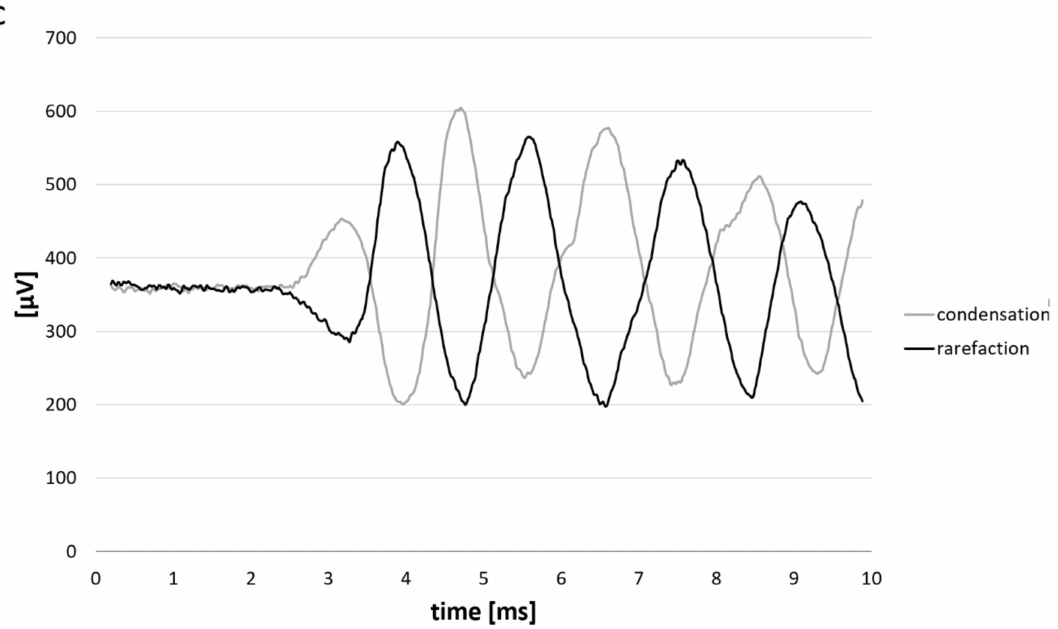
Figure 1. Figure ( A ) Example of an estimated BM delay to a 500 Hz tone burst travelling wave. ( B ) Example of an intracochlear ECochG recordings (black line) and the latency when the CM reached 10% of the maximum amplitude t 10% and the latency at the 1st maximum peak t max . The grey line is the BP-filtered signal. The stimulus used was a 500 Hz tone pip applied at 0 ms. ( C ) Example of condensation and rarefaction stimulus recordings (grey and black line,